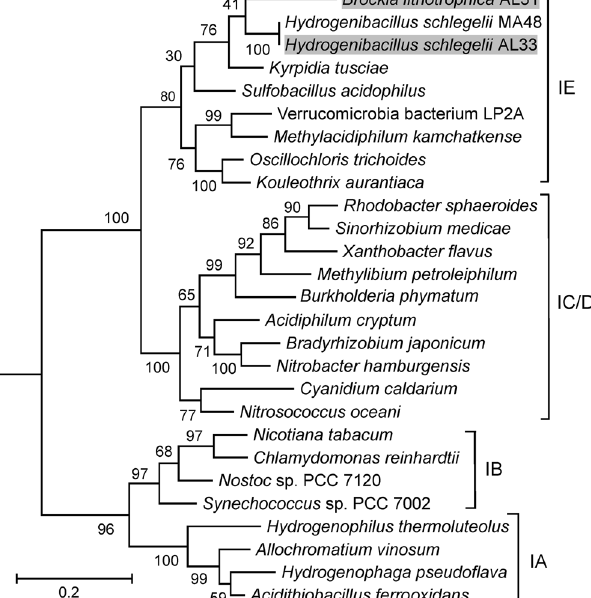
Figure 6. Maximum likelihood phylogenetic tree of deduced protein sequences of the large subunit of RuCisCO. Numbers at nodes represent bootstrap values (100 replications of the original dataset), only numbers above 50% are shown. The scale bar represents the average number of substitutions per site. The accession numbers for the sequences are given at the right side of species